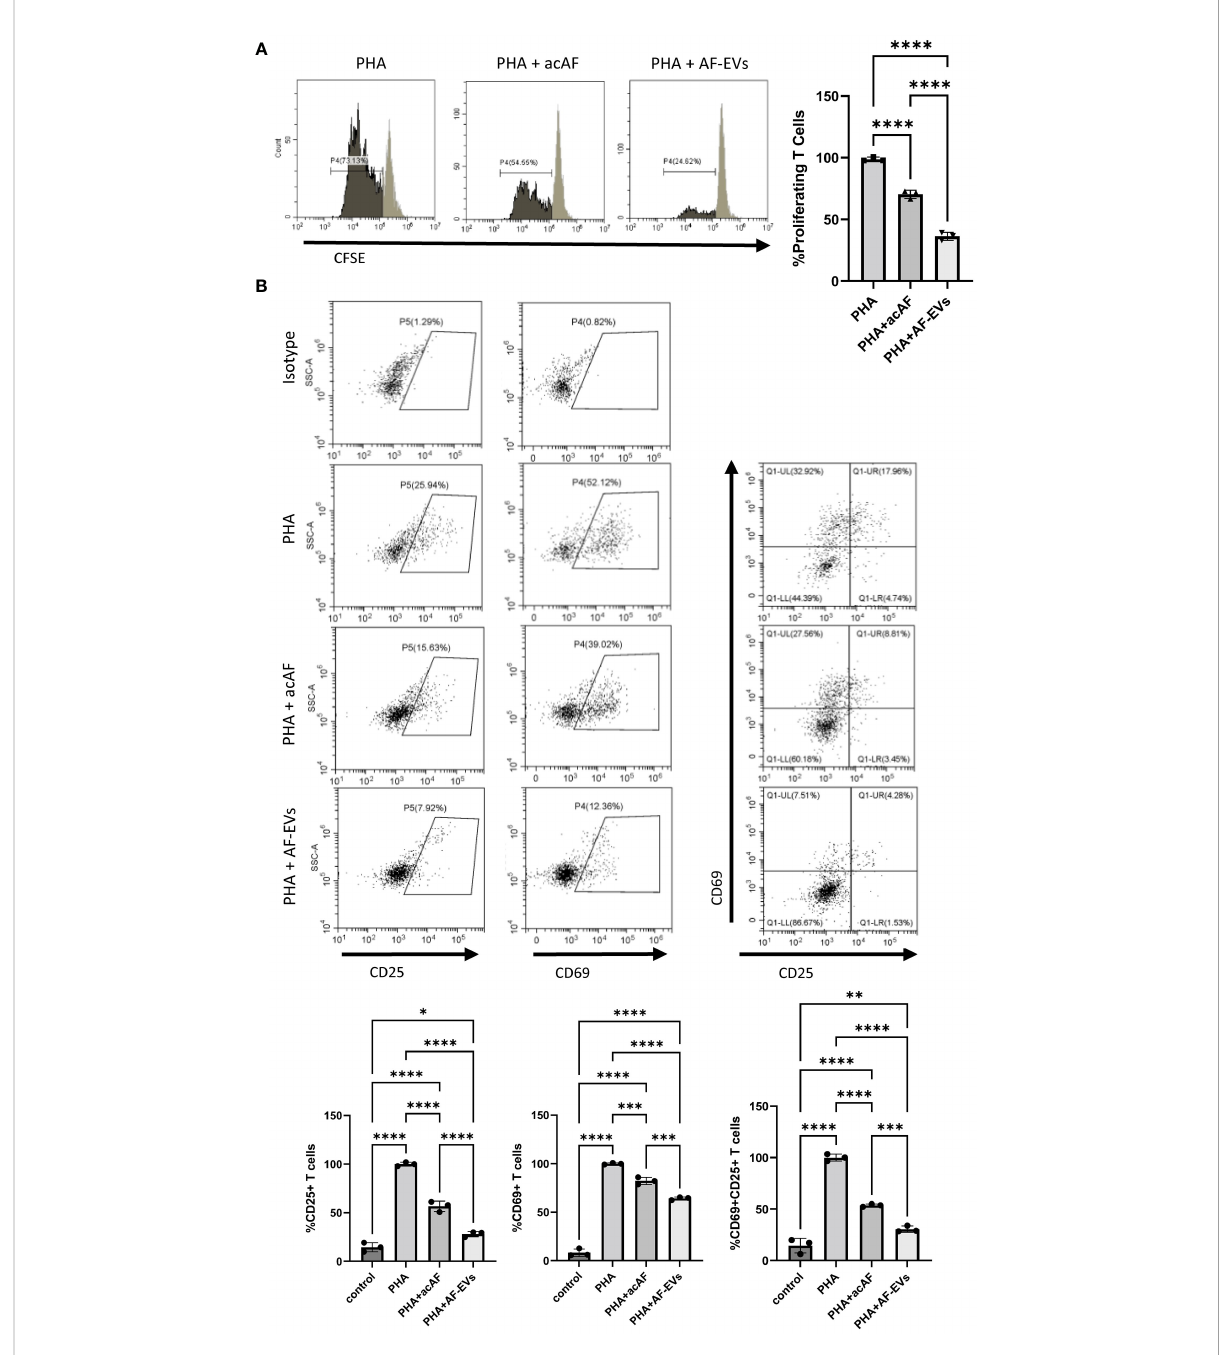
FIGURE 4 Concentrated AF-EVs Have a Greater Effect on T Cell Proliferation and T Cell Activation than acAF (A) Representative histograms and proliferating CD3+ T cells in each group graphed as percentages of the PHA vehicle control group after 5 days of culture (B) CD69+ and CD25 + cells were gated from CD3+ T cell population. Percentages of cells expressing CD69, CD25, and both CD69 and CD25 were analyzed within T cell population in each group and graphed as percentages of the PHA vehicle control group after 3 days of culture. (Data graphed as mean ± SD; One way ANOVA with Tukey ’ s test; n=3-4 for each group; *=p<.05 **=p<.01; ***=p<.001; ****=p<.0001; Data is derived from 3 separate experiments. Each experiment used 1 independent PBMC donor treated with 1 of 2 acAF and 1 of 2 AF-EV